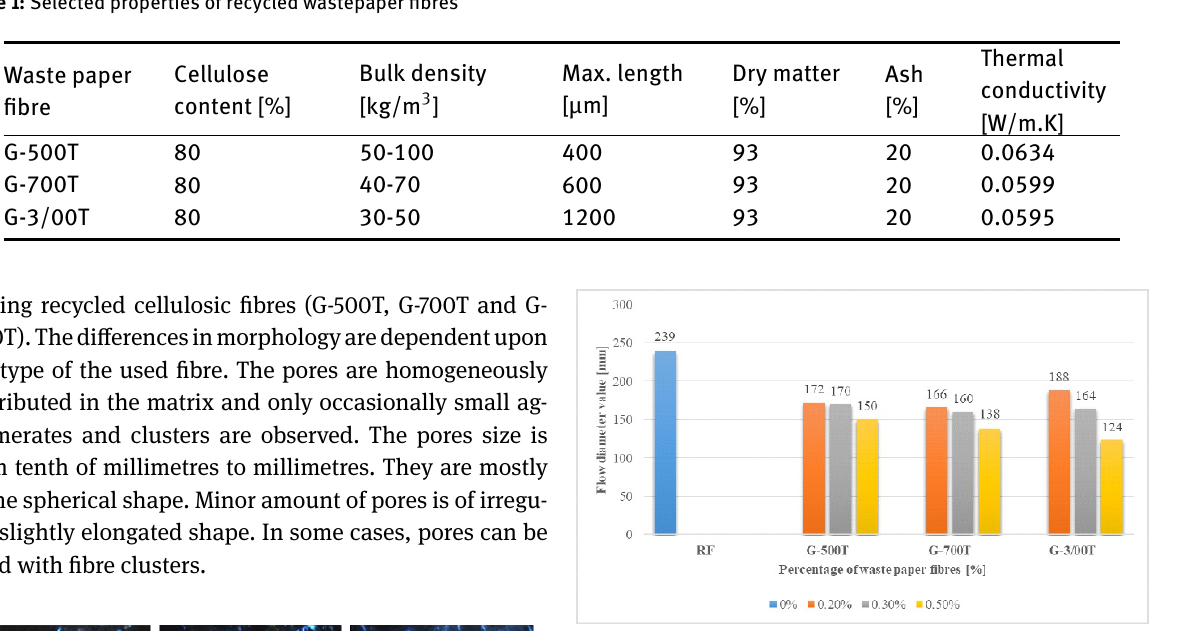
Figure 3: Flow diameter values of cement composites with waste paper